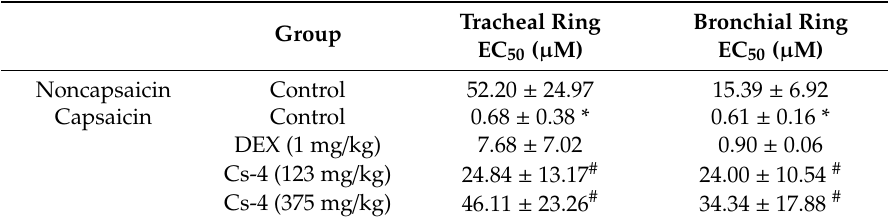
Table 3. The effect of Cs-4 on the airway responsiveness (AHR) in capsaicin-challenged rats in vitro. AHR was estimated by the minimum inhibitory concentration (EC 50 ) of methacholine (Mch)-induced contractions, which were assessed by measuring the lumen area of the tracheal or bronchial rings. Values given are mean ± SEM.